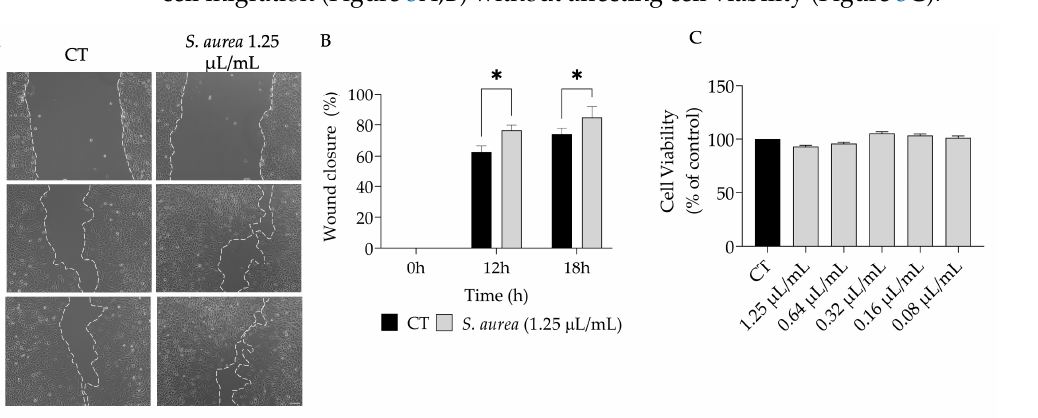
(1.25 µ L/mL) at 0 h, 12 h, and 18 h post-scratch. ( B ) Expresses the percentage of a closed “wound”. ( C )